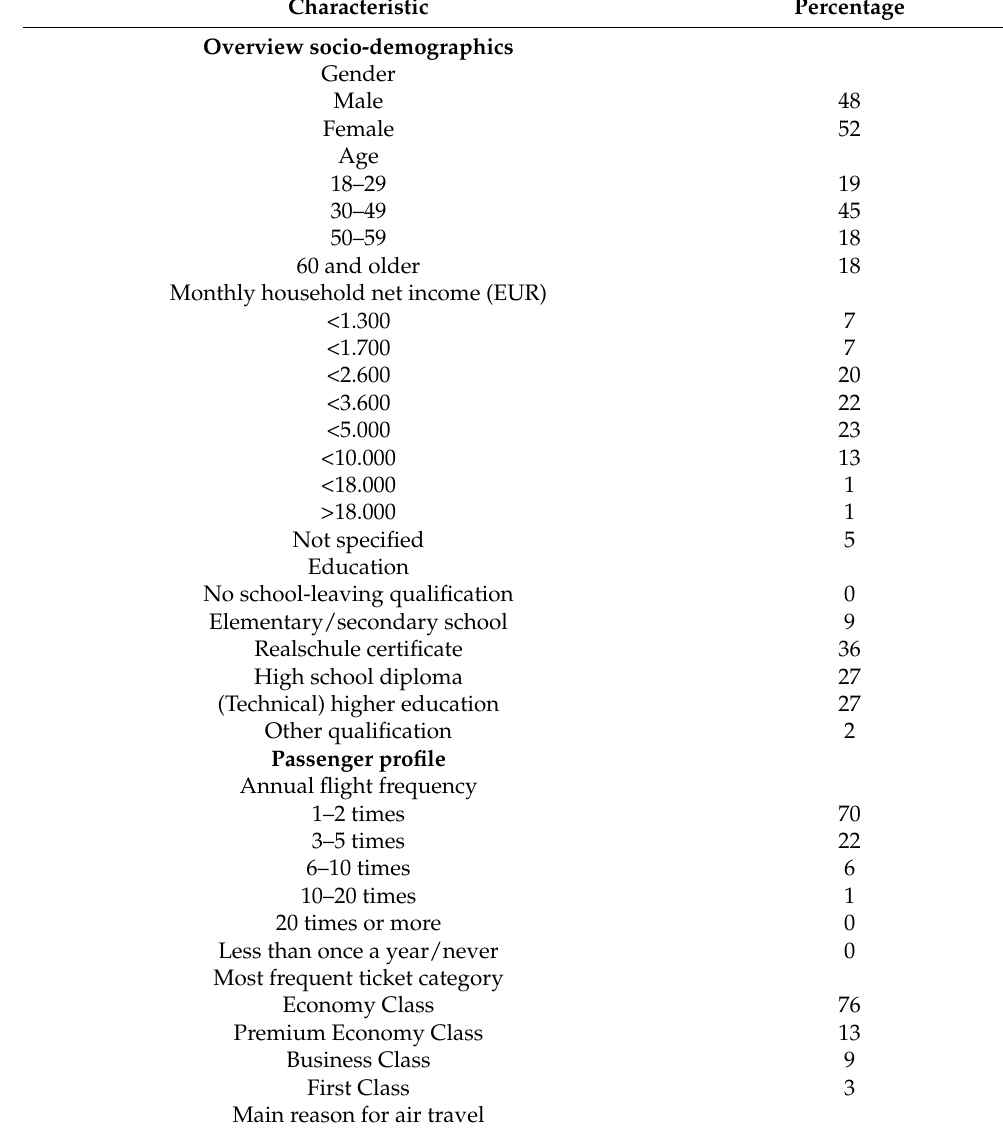
Table A3. Survey socio-demographic